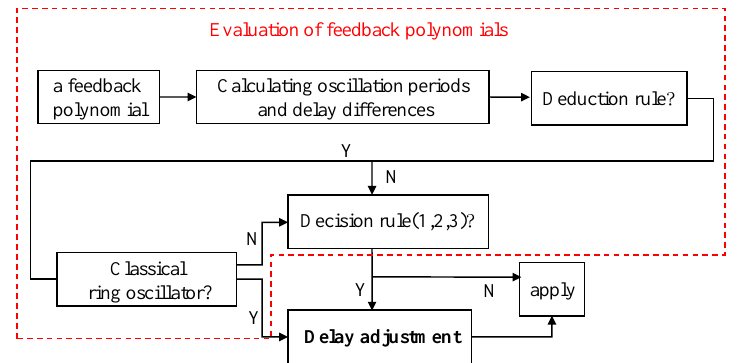
Figure 20: The design